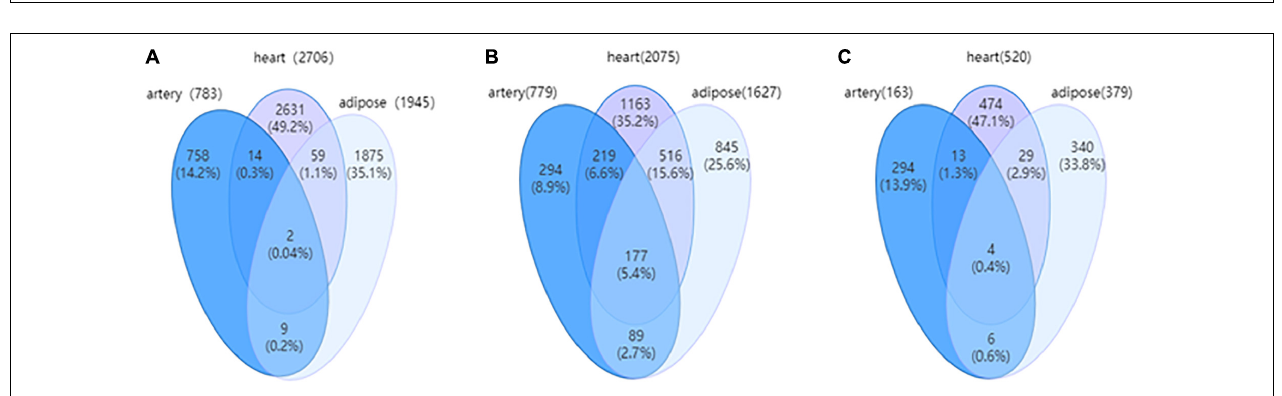
FIGURE 3 | Two housekeeping differentially correlated gene pairs (DCGs). (A) List of housekeeping DCGs. (B) Function enrichment results of housekeeping DCGs.